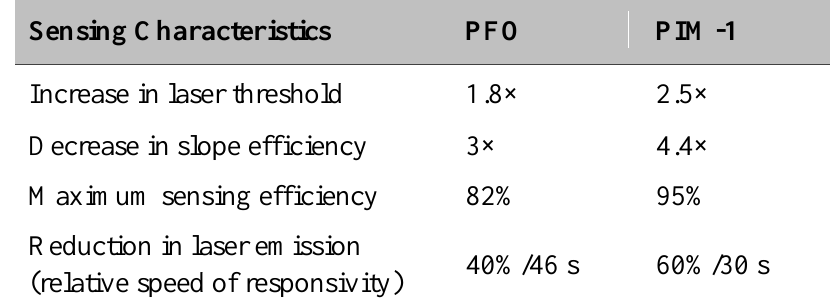
Table 1. Comparison between explosive sensing properties of PIM-1 and PFO laser sensors—both exposed to ~10 ppb DNB for 5